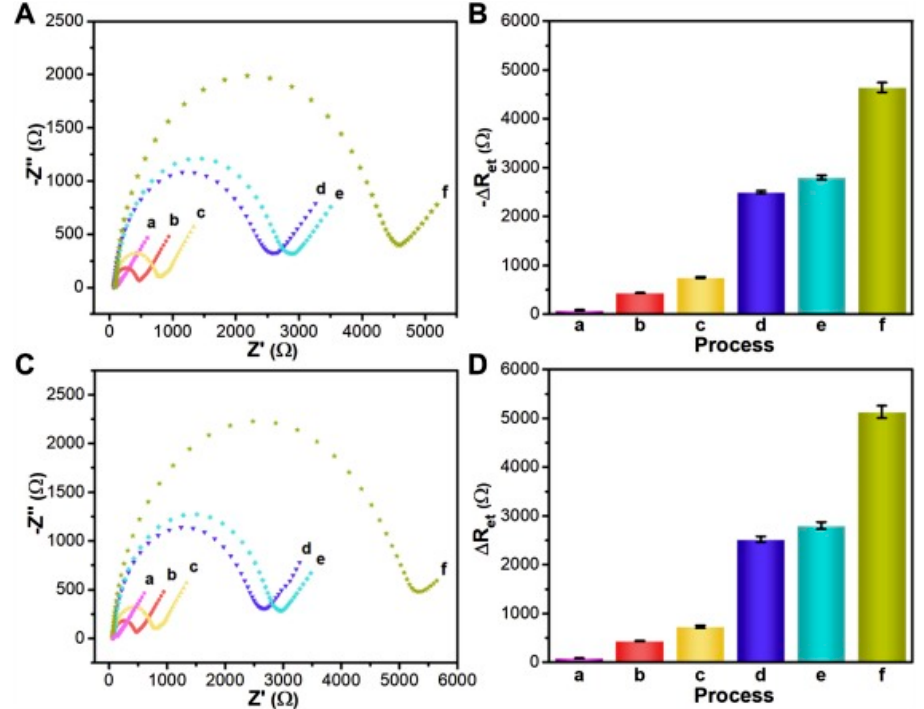
Figure 4. Impedimetric prostate-specific membrane antigen (PSMA) sensor fabrication (a–e) and operation (f): Nyquist plots ( A ), ( C ) and corresponding charge transfer resistance calculated using the alternative circuit. ( A ) and ( B ) correspond to one specific phage clone, whereas ( C ) and ( D ) present result for another phage clone applied in the sensor. Reprinted from [58], Copyright 2019, with permission from Elsevier.